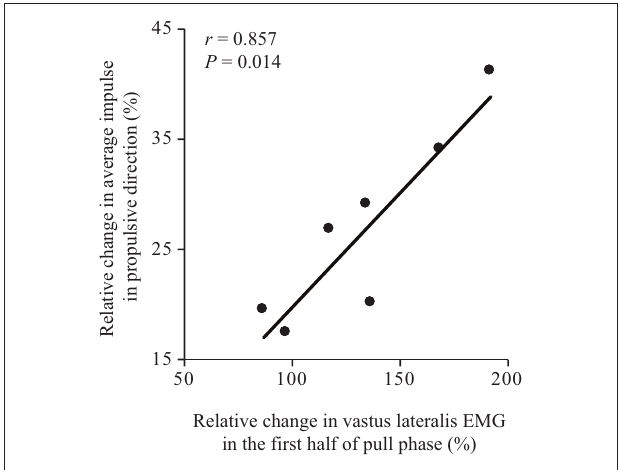
FIGURE 1 | Relationship between relative change in propulsive average impulse and vastus lateralis EMG, with four-week kayak training. The regression line is shown because the relationship was found to be